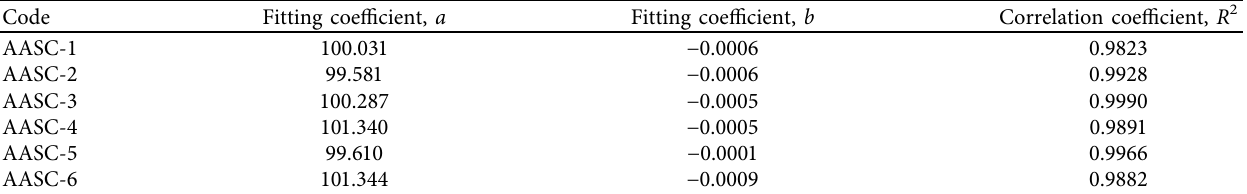
Figure 16: Relative dynamic elastic modulus attenuation exponential function model. Table 13: Relative dynamic elastic modulus attenuation exponential function and pertinence coefficient.